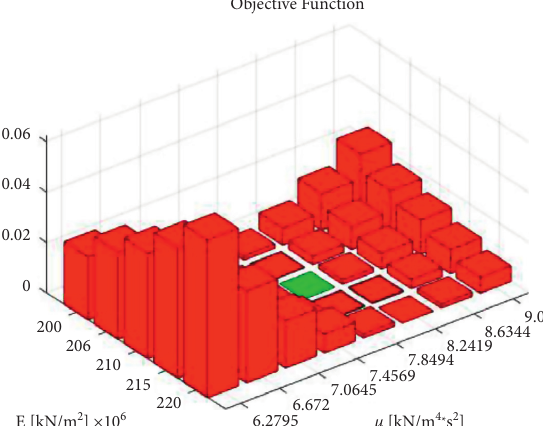
Figure 6: Calibration of mechanical parameters.